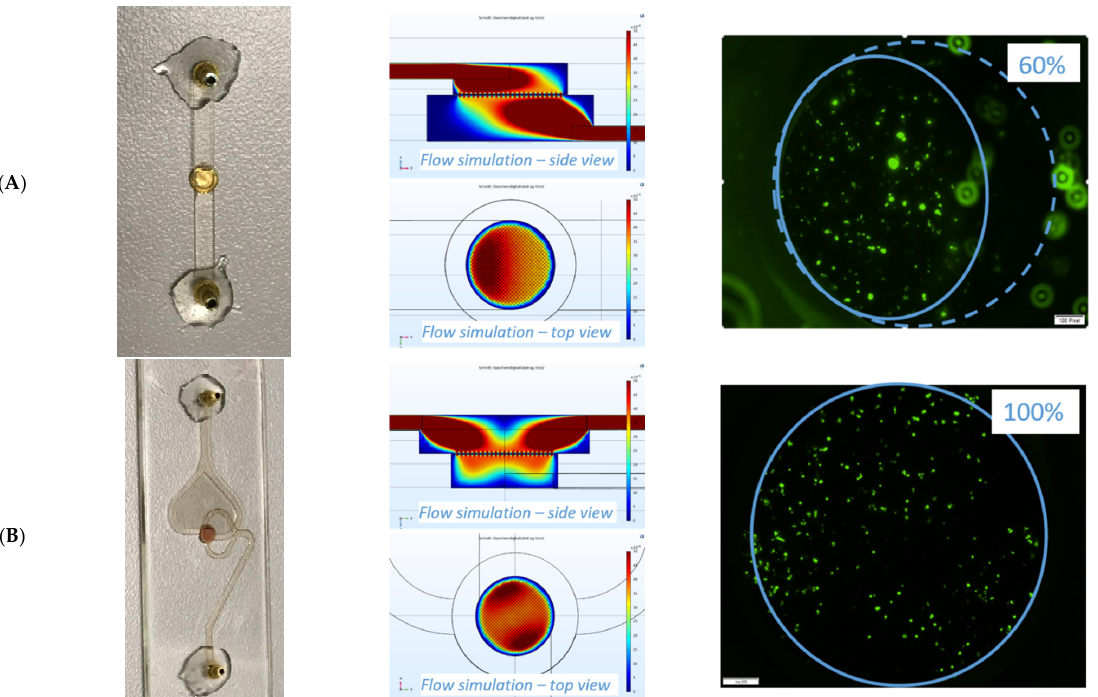
Figure 4. Design, simulation, and experimental determination of flow through area for cell retention on two filter holder designs. Design ( A ) contained a single inlet and outlet channel on the top and bottom of the slide. A flow rate of 2 µL/s resulted in a flow through area of ~60%. For the adapted design ( B ), the inlet was divided into two strands, which reach the filter the opposite way and slightly offset. Furthermore, the outlet was divided into two strands leaving the filter at 90 degrees from the inlets. A flow rate of 2 µL/s resulted in a flow through area of close to 100%. As shown in Figure 5, the improved flow through also led to improved capture rate,